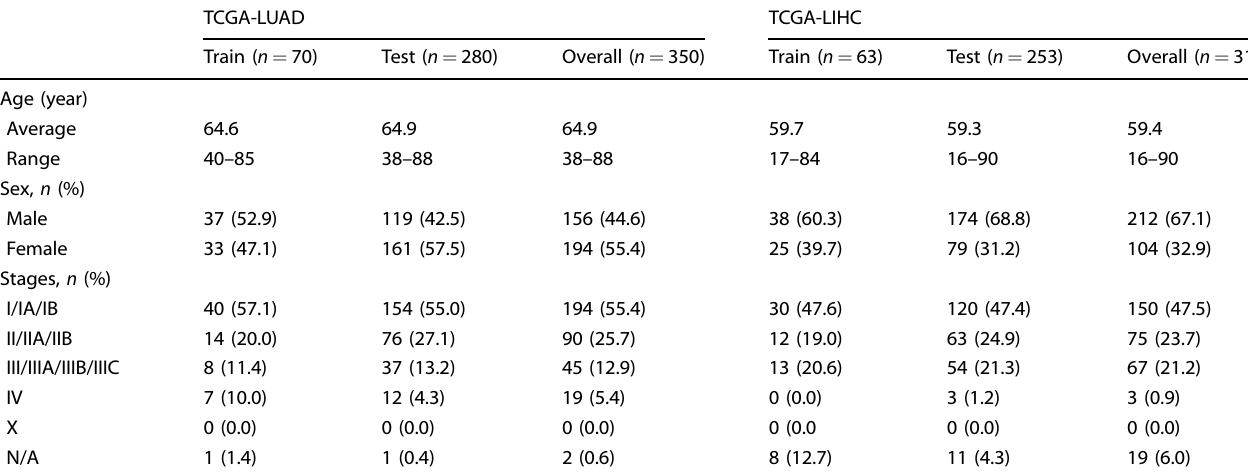
Table 2. Patient characteristics on the 350 cases from TCGA-LUAD cohort and 316 cases from TCGA-LIHC